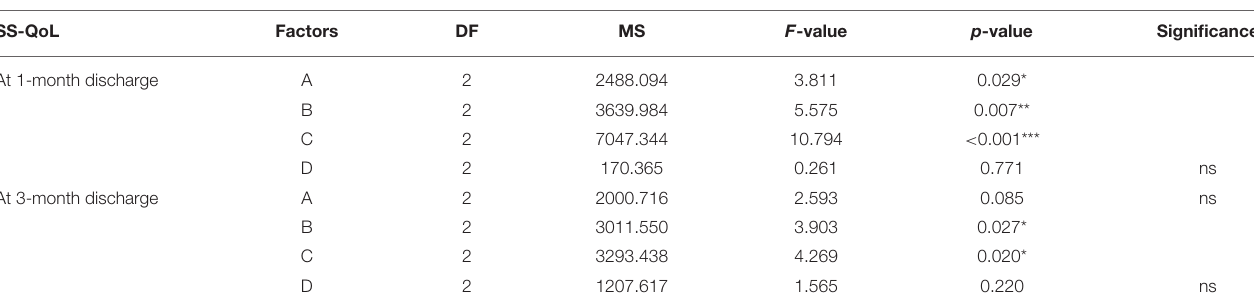
TABLE 10 | ANOVA of the factors affecting the quality of life. SS-QoL